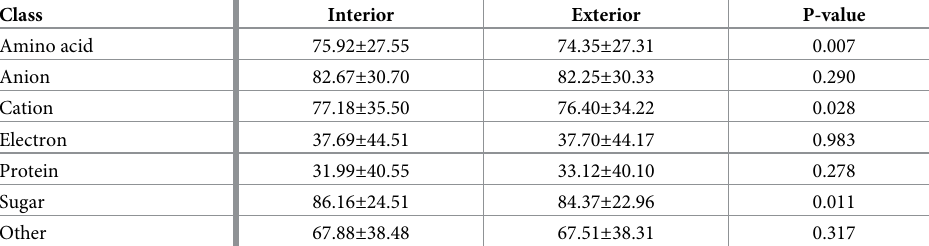
All the data are reported as the sample mean ± the standard deviation (SD). For the TMS regions, there is no difference between the informative positions in the interior central one-third of the TMS regions and the remaining exterior regions, in all sequences that belong to all substrate